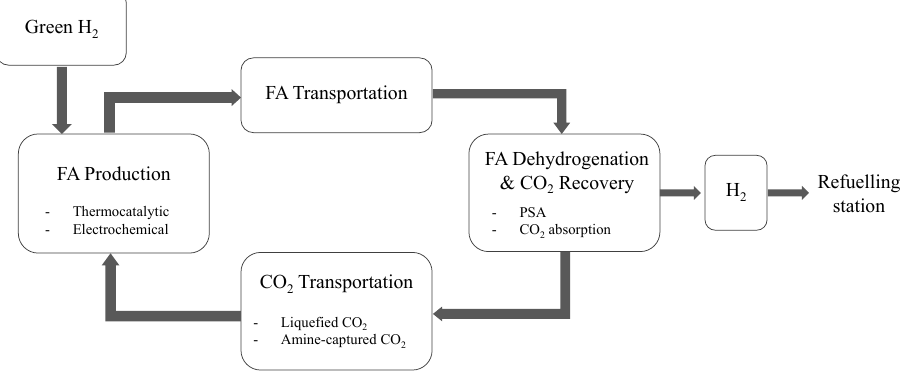
Figure 6. Overview of the H 2 distribution cycle using FA as an LOHC. Different options for each step of the process are